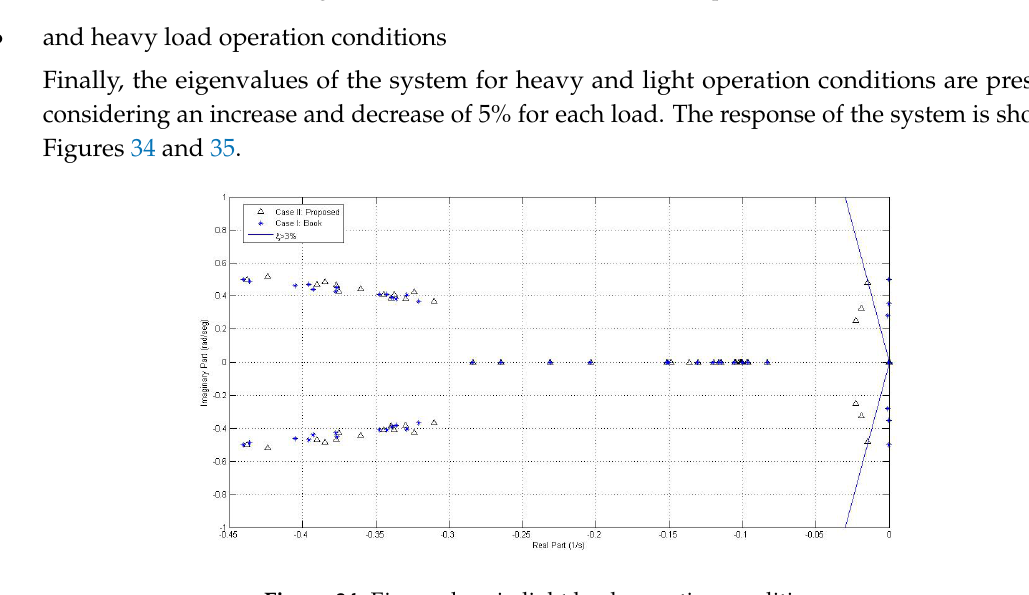
Figure 33. Rotor angle [rad] and Active Power [MW]-three phase fault at Line 60–61.